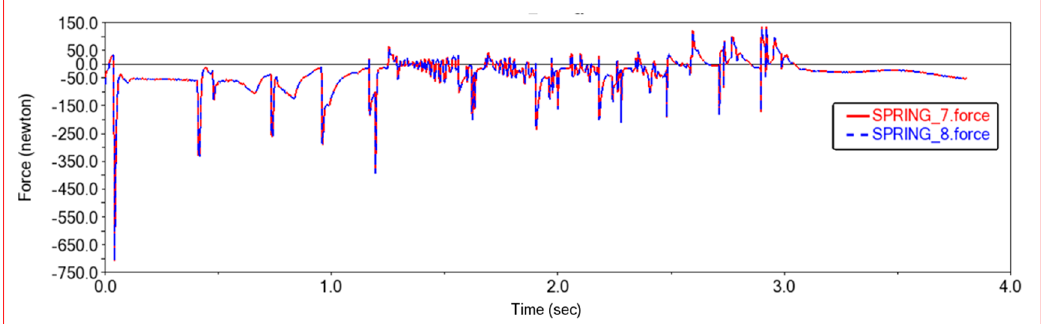
Figure 17. Force diagram of rear frame shock absorber in Experiment 2. SPRING-7-Rear frame left shock absorber; SPRING-8-Rear frame right shock absorber.